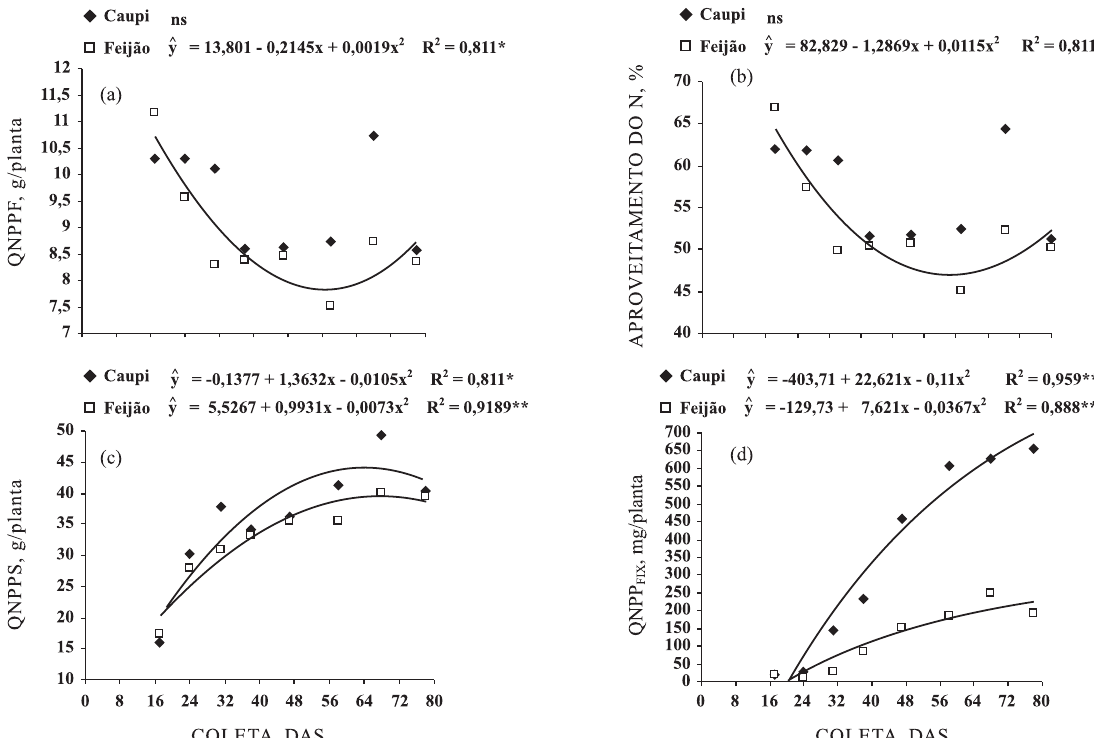
Figura 4. Quantidade de nitrogênio proveniente do fertilizante (QNPPF) (a) e aproveitamento do N do fertilizante (b), quantidade de nitrogênio proveniente do solo (QNPPS) (c) e da fixação simbiótica (QNPPFIX) (d) na parte aérea (caule + ramos + folhas + pedúnculos e vagens) do feijão-comum e caupi. **, * e ns: significativo a 1 e 5 % e não significativo,